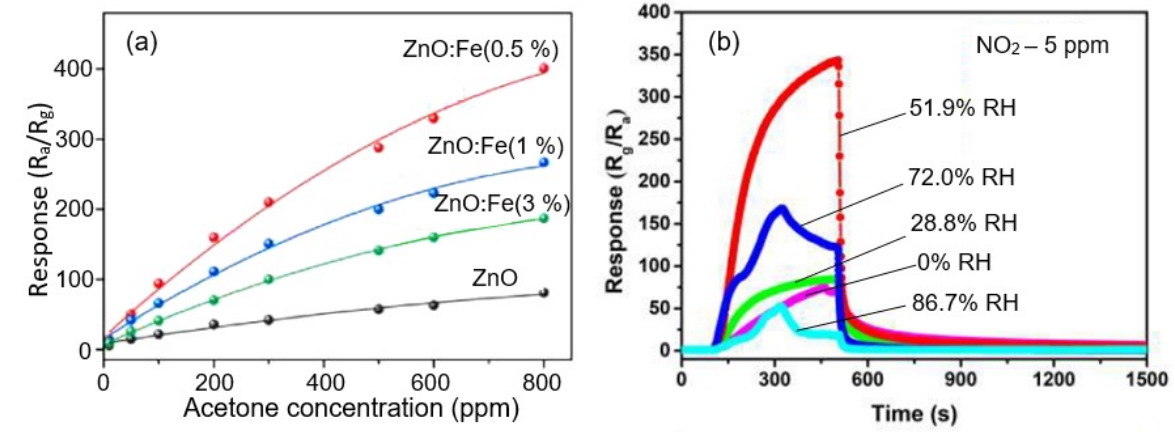
Figure 24. ( a ) The response of sensors based on pure ZnO and 0.5%, 1%, and 3% Fe–ZnO to 50 ppm acetone at 365 °C. Reprinted with permission from Chen et al. [155]. Copyright 2022: Elsevier; ( b ) Dynamic response curves of the In 2 O 3 /MoS 2 sensor to 5 ppm NO 2 in various humidity at RT. Reprinted with permission from Zhang et al. [156]. Copyright 2022: Elsevier.